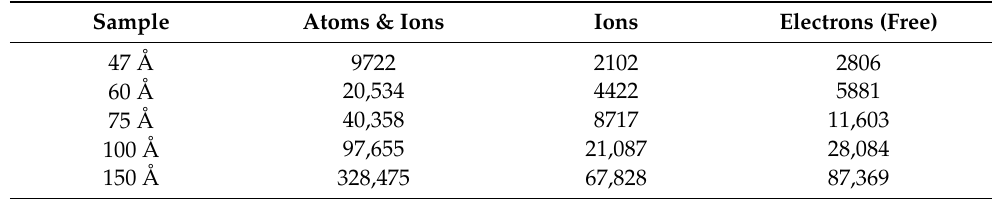
Table 1. Simulated water samples, with specified total number of atoms and ions (including all charge states), ions (of charge +1 and higher), and free electrons. Sample Atoms & Ions Ions Electrons (Free) 47 Å 9722 2102 20,534